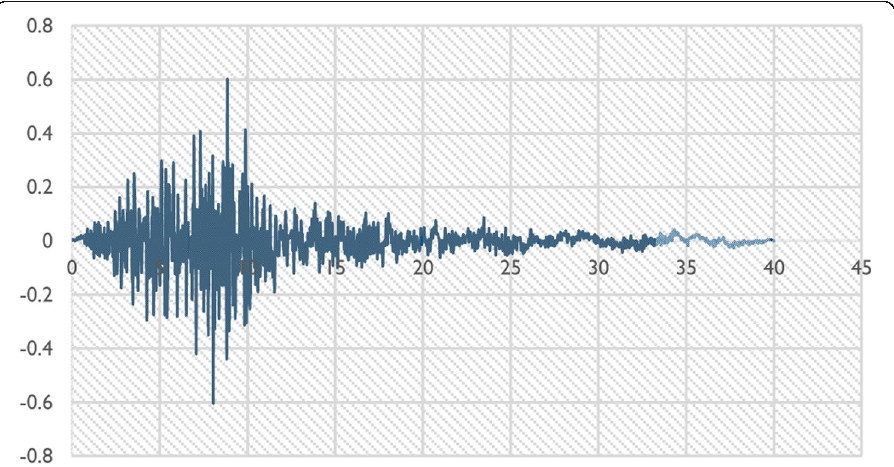
Fig. 15 Scaled artificial accelerogram (P.G.A. = 0.60